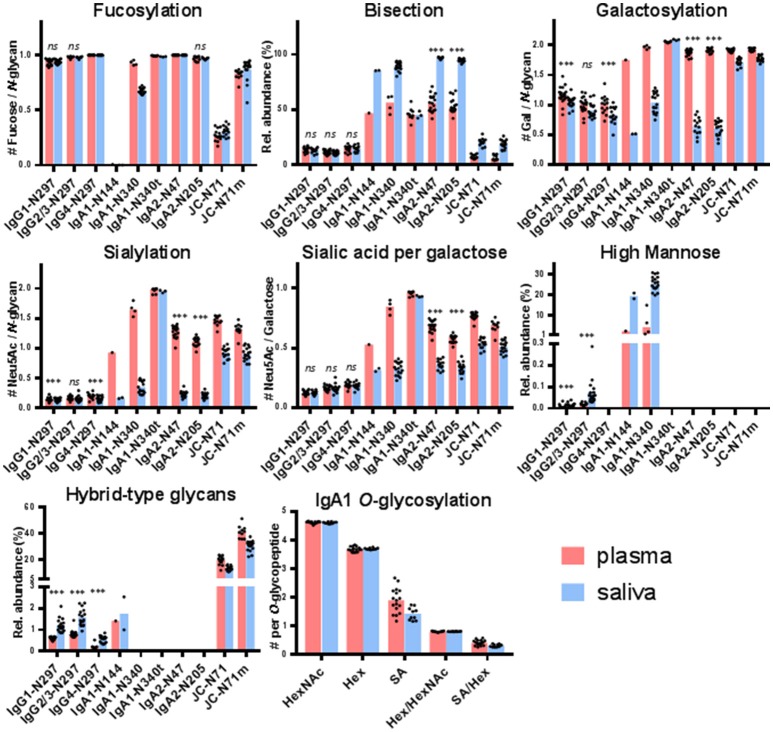
Glycosylation features for each of the glycosylation sites found in IgG, IgA, and the JC. The bar graphs represent the medians per glycosylation site (red for plasma and blue for saliva) and the black dots represent the individual data points for each donor. A Wilcoxon signed rank test was performed between paired samples from plasma and saliva when the total number of pairs was > 10 (Supplemental Table S4). Significant differences are denoted by ***, non-significant differences are denoted by ns. IgA1-N340t is the C-terminally-truncated version of IgA1-N340 and JC-N71m is the miscleavage variant of JC-N71. IgA1-N144 also represents IgA2-N131, and IgA1-N340 and -N340t also represent IgA2-N327 and -N327t.